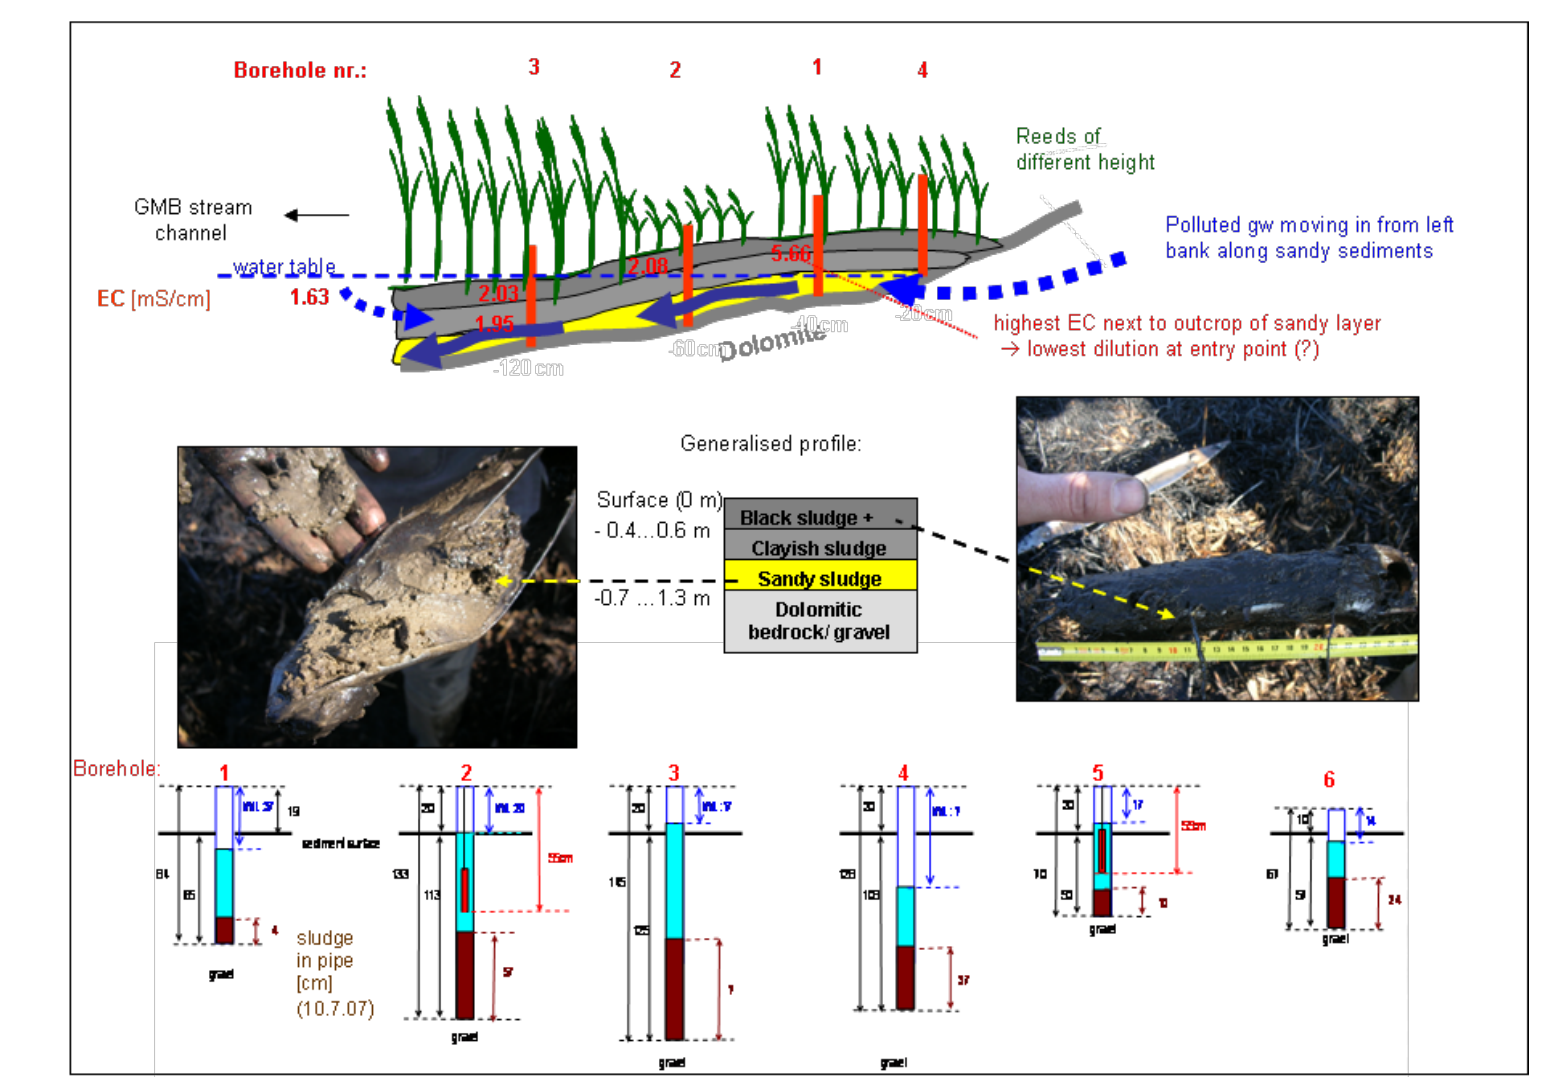
Figure 13. Simplified cross section depicting the near-surface geological underground along the borehole transect at portion 7 (upper part) including a generalized soil profile (middle part) and the depth of each borehole (lower